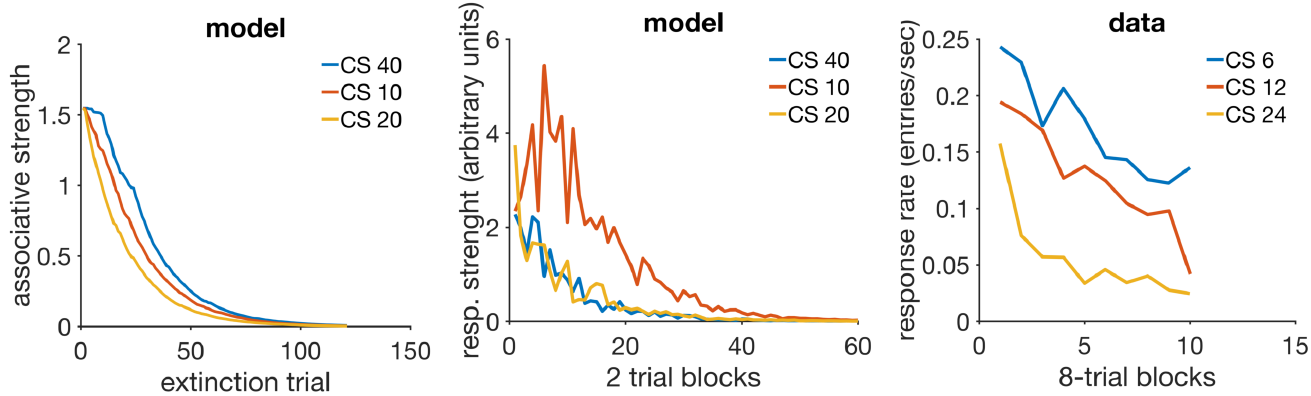
Fig 5. Extinction curves. Left panel: model V values for each CS durationin extinction. Middlepanel: simulatedCR values calculatedonly for the first 10 seconds of the CS. Each data point is calculatedby summing the output of eq (10) over the first 10 sec of each trial, then averagingthese trial values two by two, and dividingby 100 to rescale. Right panel: actual CR data for the first 6 sec of the CS in extinction,redrawn from Figure 8 (C) in [80].